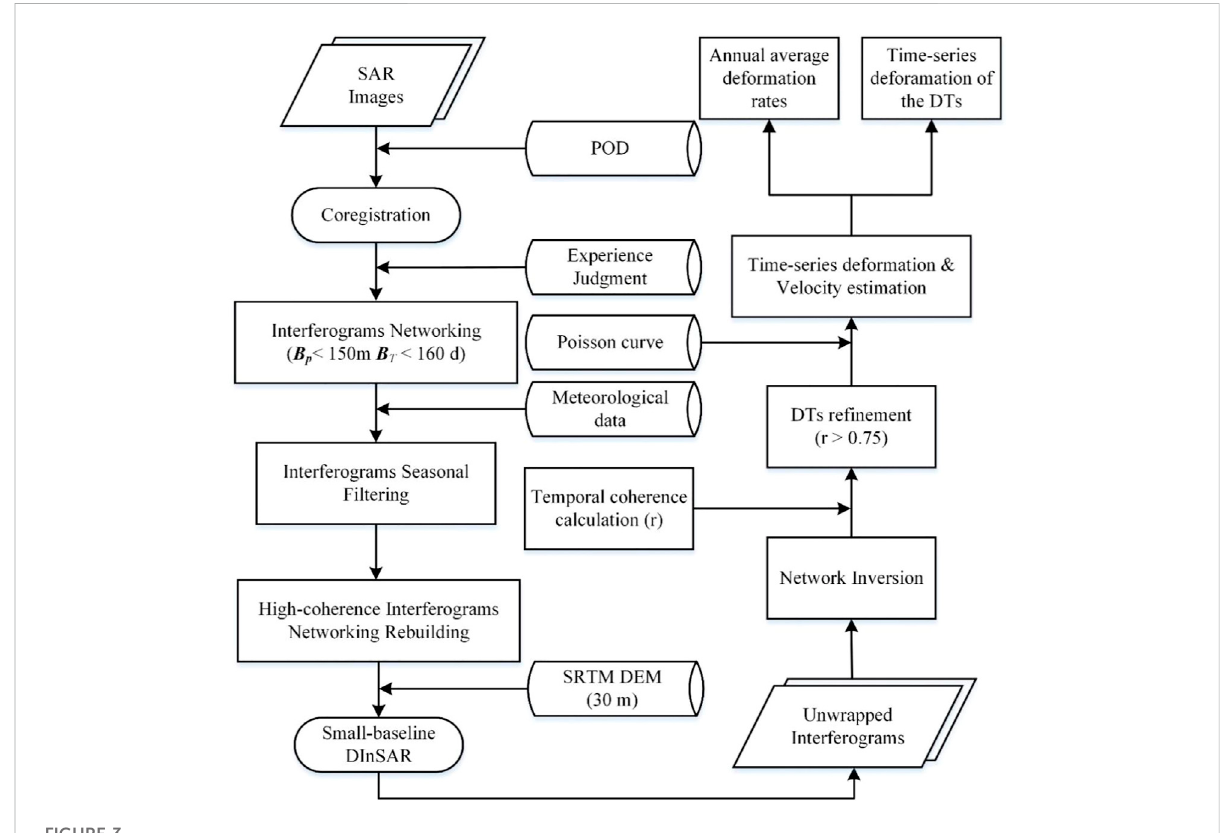
FIGURE 3 Work- fl ow of the optimized